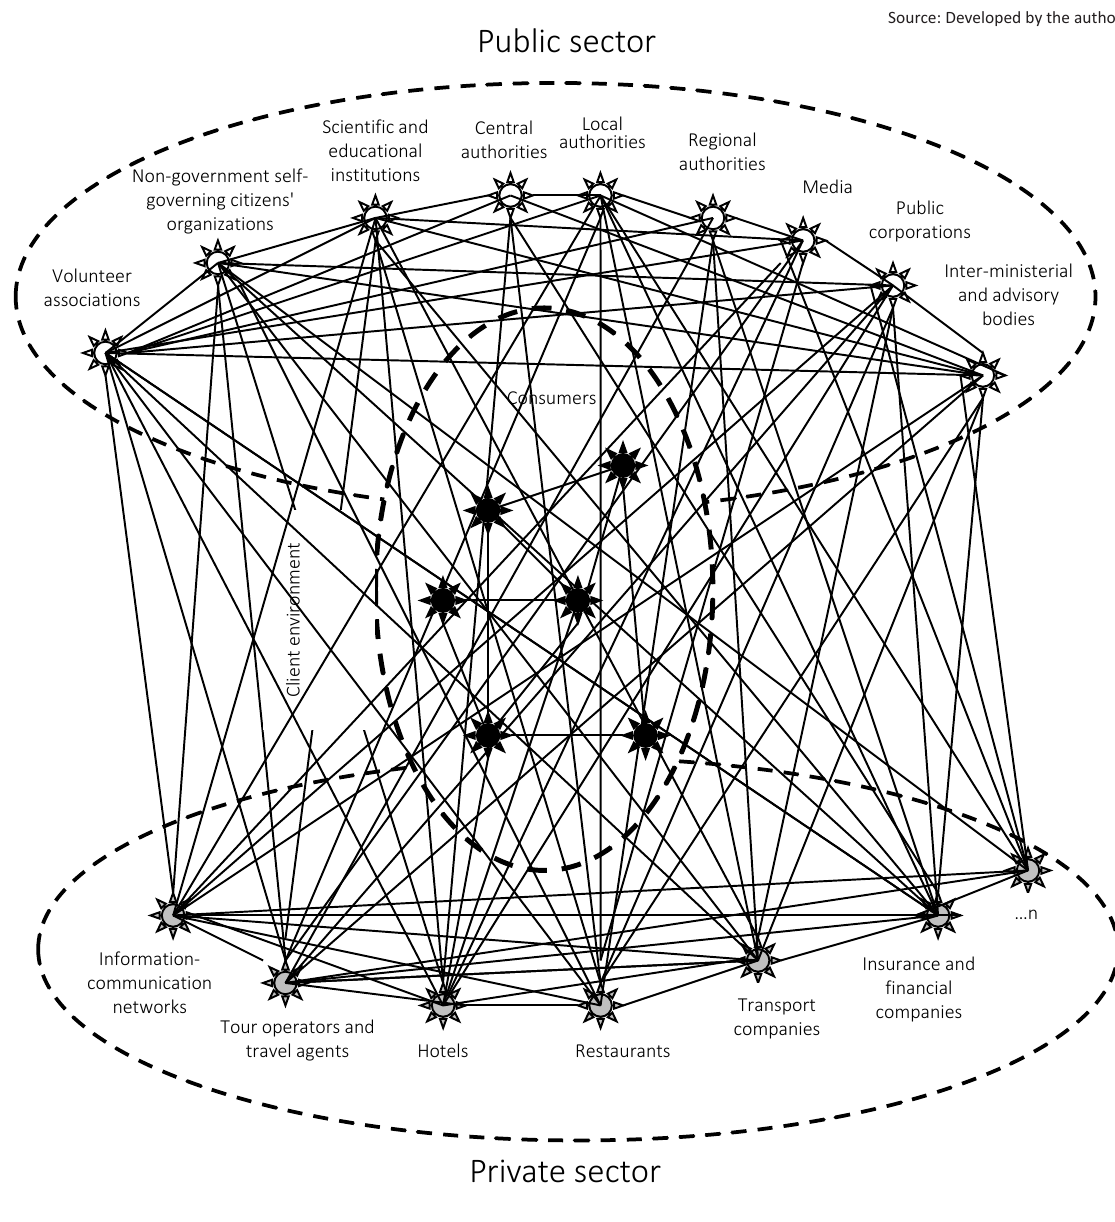
Figure 1. Configuration of multisubject NTS